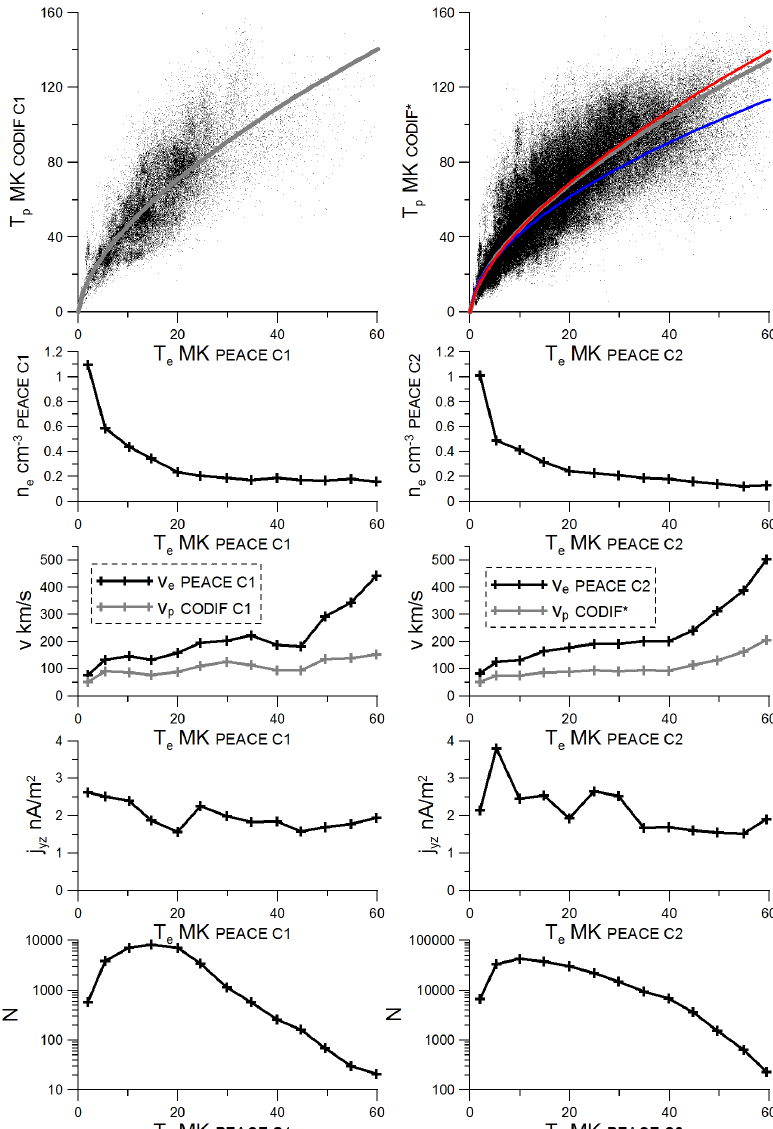
Fig. 2. Top panels: proton temperature T p versus electron temperature T e for both statistics described in text (CODIF*: data from C4 for 2001-2003 and data from C1 for 2004). Also the approximations T p = CT σ e are shown (see text for details). Middle panels: averaged value of electron density n e , electron and proton bulk velocities v e and v p and curlometer current density j zy as functions of T e . Bottom panels: number of points in statistics for corresponding value of T e